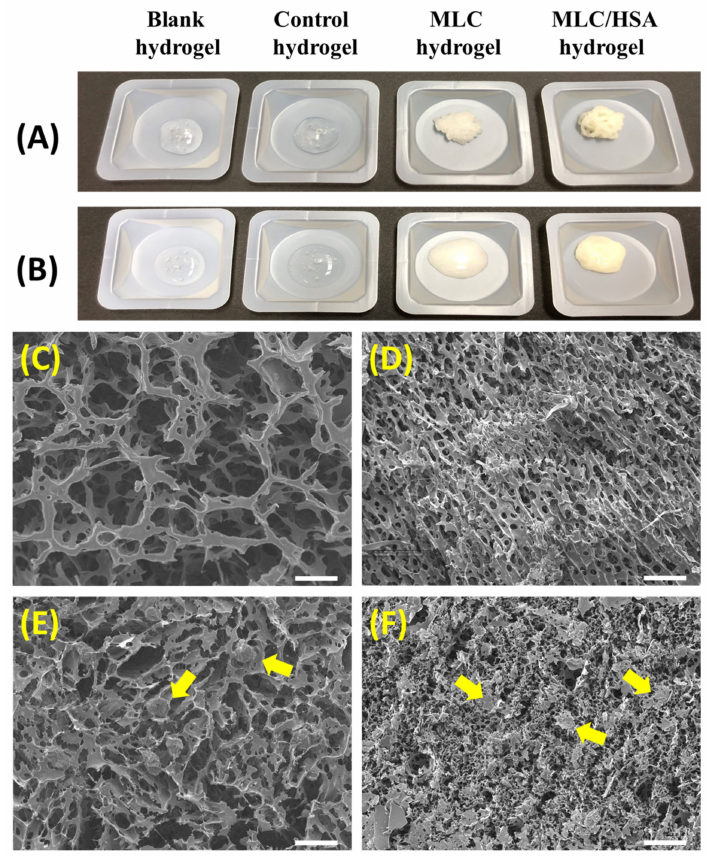
Figure 3. Morphology of the hydrogel formulations. ( A ) Optical appearance of the hydrogels observed immediately after passing through the syringe. ( B ) Optical appearance of the hydrogels after 1 h. FE-SEM images of ( C ) the blank hydrogel, ( D ) the blank hydrogel with albumin, ( E ) the MLC hydrogel, and ( F ) the MLC/HSA hydrogel. The length of the scale bar in SEM images is 30 µ m. Yellow arrows indicate